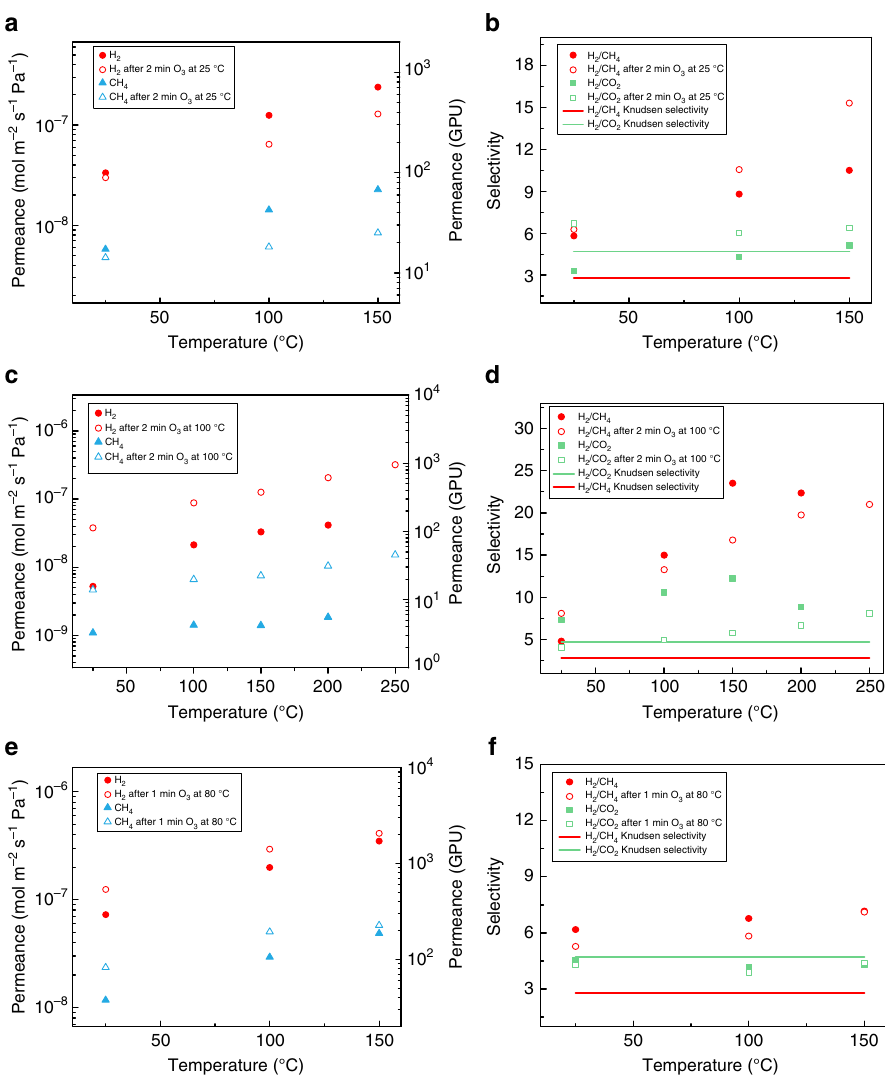
Fig. 7 Gas separation performance of ozone-treated graphene membranes. a , b Gas separation performance of M2 treated by 2 min O 3 at 25 °C, a gas permeance of H 2 and CH 4 , b gas selectivity of H 2 /CH 4 and H 2 /CO 2 . c , d Gas separation performance of M8 treated by 2 min O 3 at 100 °C, c gas permeance of H 2 and CH 4 , d gas selectivity of H 2 /CH 4 , and H 2 /CO 2 . e , f Gas separation performance of M6 treated by 1 min O 3 at 80 °C, e gas permeance of H 2 and CH 4 , f gas selectivity of H 2 /CH 4 and H 2 /CO